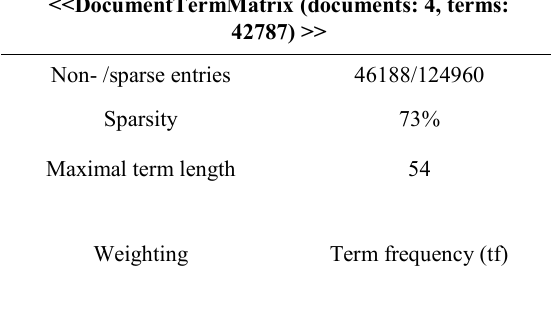
Table 4. Evaluation of terms and